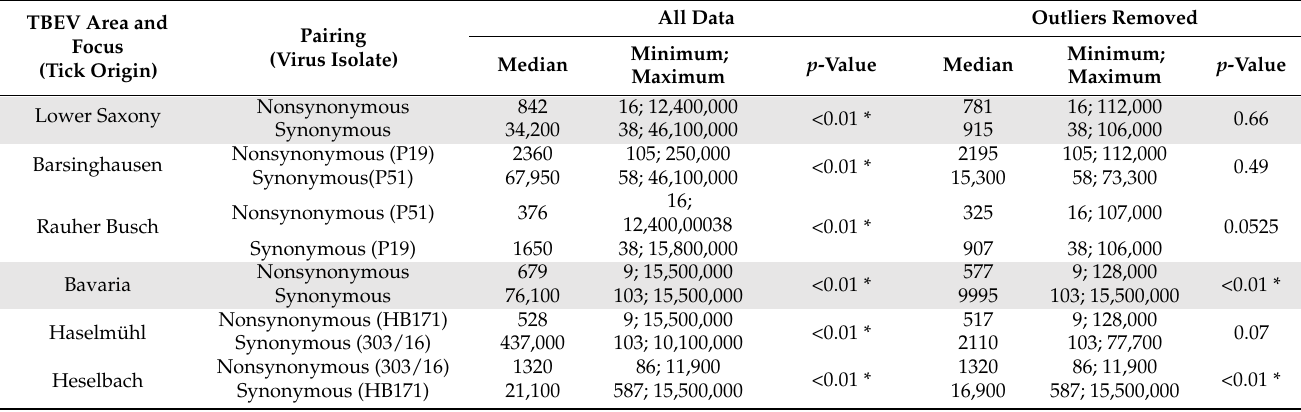
Table 2. Analysis of synonymous and nonsynonymous pairing of TBEV isolates and tick population on TBEV RNA copy numbers per infected tick separately for Lower Saxony and Bavaria. The p -values were calculated by the Mann-Whitney U